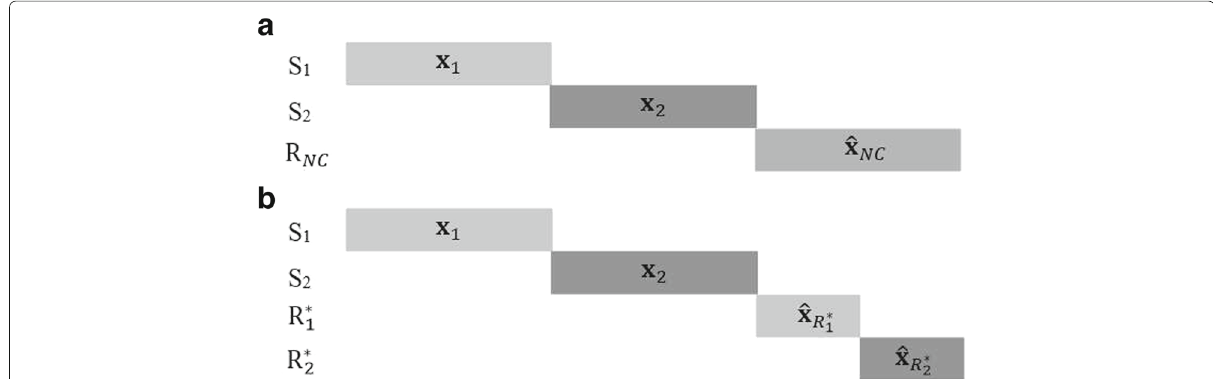
Fig. 2 Time allocation. a Network coding-based cooperation—one relay is selected which forwards the whole network-coded codeword to help the two sources simultaneously. b Partial relaying-based cooperation—two relays are selected, each forwarding half of estimated codeword to help one source